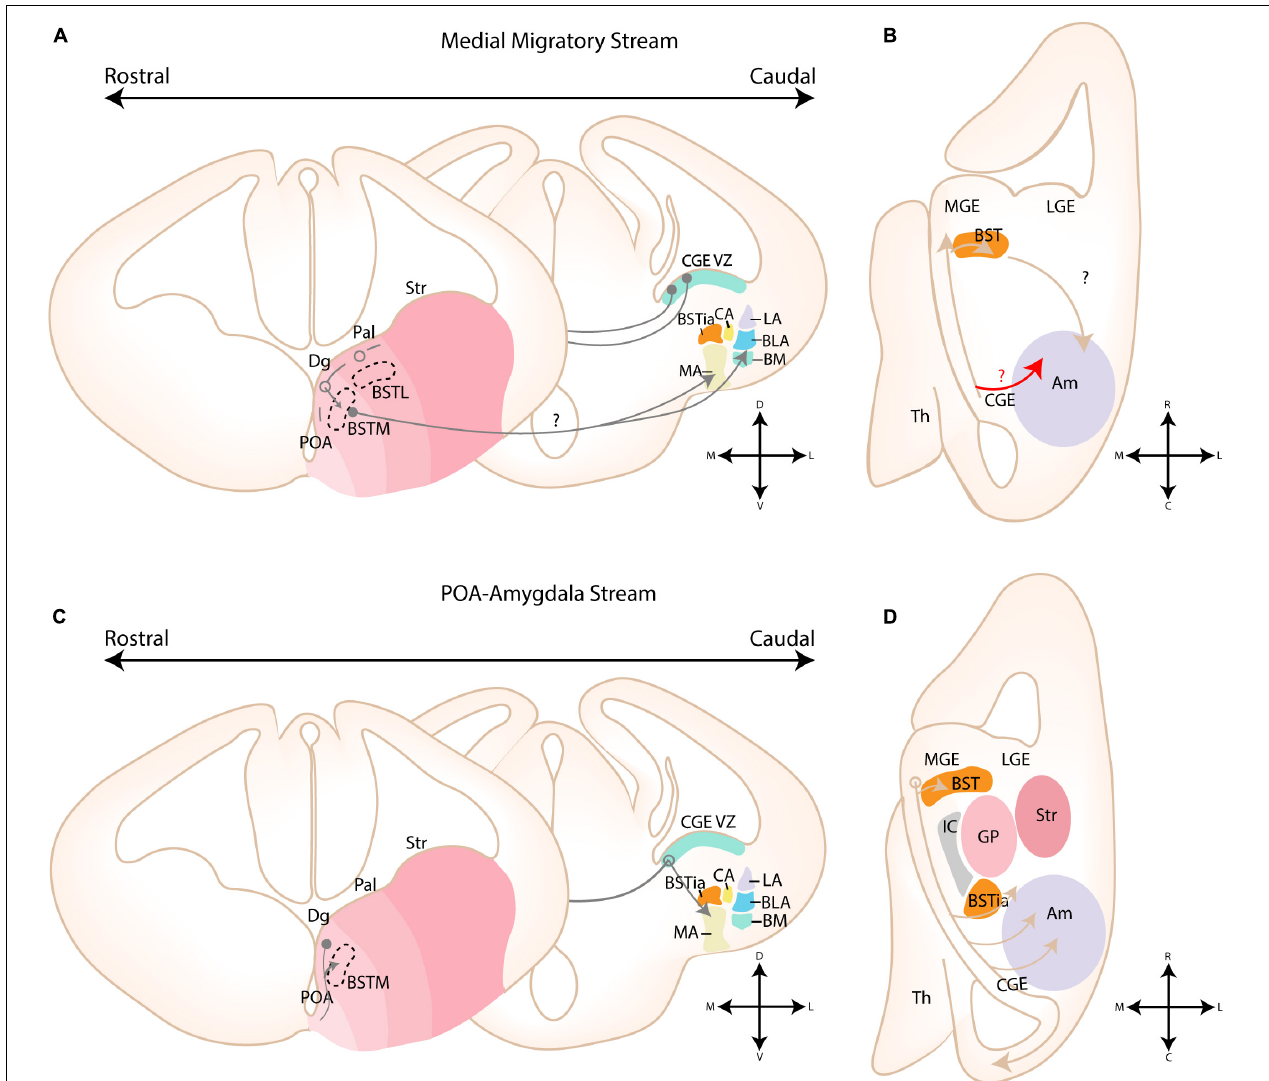
FIGURE 7 | Migratory routes of cells through the medial and POA-amygdala migratory streams. (A) Schematic coronal sections showing the putative migratory route of CGE-derived cells within the medial migratory stream. 5HTaR-expressing interneurons originating in the ventricular zone of the CGE (CGE VZ) take a rostral route toward the MGE, where they invade the medial part of the bed nucleus of the stria terminalis (BSTM). Cells from this migratory route are hypothesized to colonize the amygdala, although a migratory route beyond the MGE has not been described. (B) Schematic horizontal section showing the putative migratory route of CGE-derived cells within the medial migratory stream. A red arrow shows an alternative migratory route of CGE-derived interneurons destined for the amygdala. (C) Schematic coronal sections showing the migratory route of POA-derived cells within the POA-Amygdala migratory stream (PAS). Cells originating in the preoptic area (POA) first migrate dorsally toward the caudoventral MGE/Diagonal area (cvMGE/Dg) region, where a subset of cells tangentially invades the BSTM, while other cells continue their migration caudally. At the level of the CGE, a subset of POA-interneurons migrate ventrally toward the primordium of the developing medial amygdala. (D) Schematic horizontal section showing the migratory route of POA-derived cells within the POA-Amygdala migratory stream. A section at the level of the Dg is shown, more dorsal than the POA. POA-derived interneurons first migrate dorsally toward the Dg area, after which they take a caudal route toward the CGE. At the level of the ventral CGE, POA-derived interneurons migrating through the PAS are joined by CGE-derived interneurons migrating through the caudal migratory stream (CMS). While a subset of POA- and CGE-derived interneurons invade the amygdala, others continue along the CMS toward the hippocampus. Str, Striatal domain; Pal, Pallidal domain; Dg, Diagonal Domain; POA, Preoptic Area; BSTL, lateral part of BST; BSTM, Medial part of BST; BSTia, intraamygdaloid part of BST; MA, medial amygdala; CA, Central amygdala; LA, Lateral amygdala; BLA, Basolateral amygdala; BM, Basomedial amygdala; Th, Thalamus; IC, Internal Capsule; GP, Globus Pallidus. Positions where cells go in the slide are shown with a filled circle, positions where cells come out of the slide are shown with an open circle.